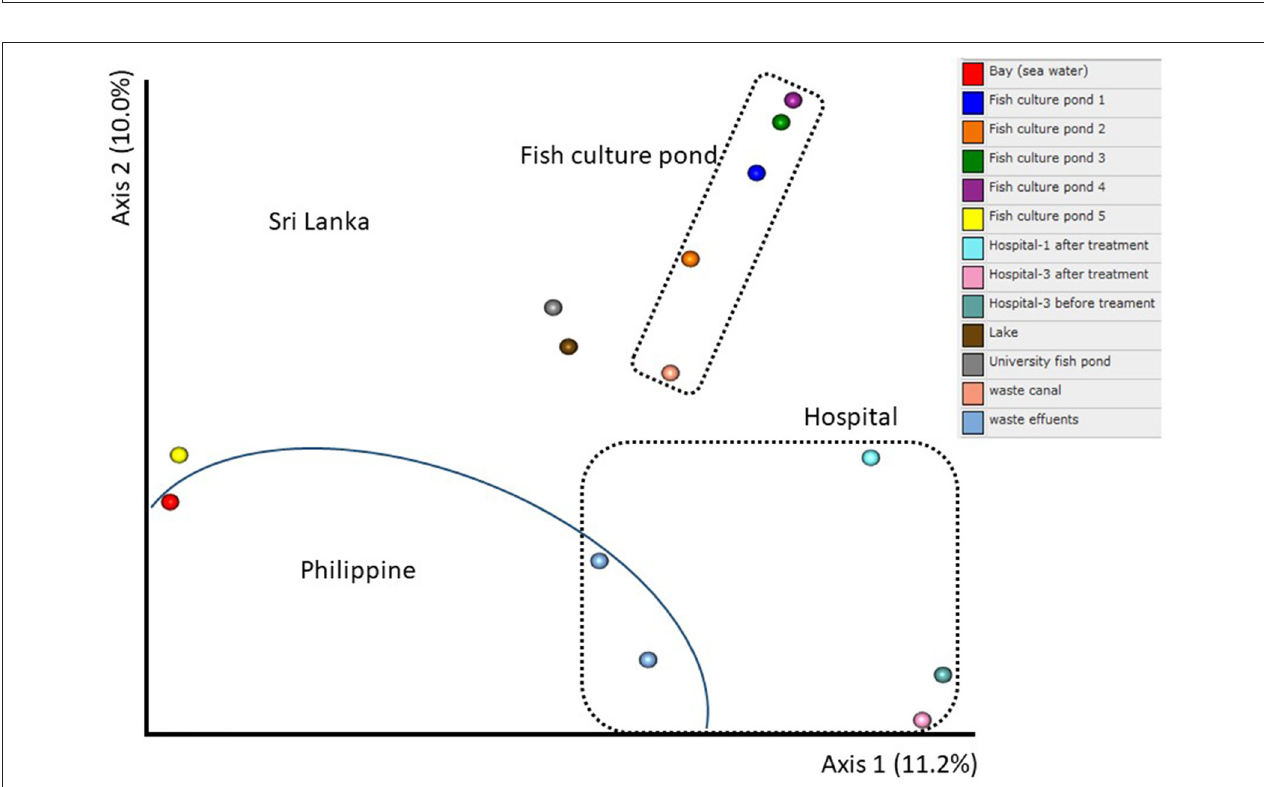
water as a response to change the environment would provide a valuable assessment of the aquatic microbial ecology and their risks (Wang et al., 2016). The distribution and composition of the